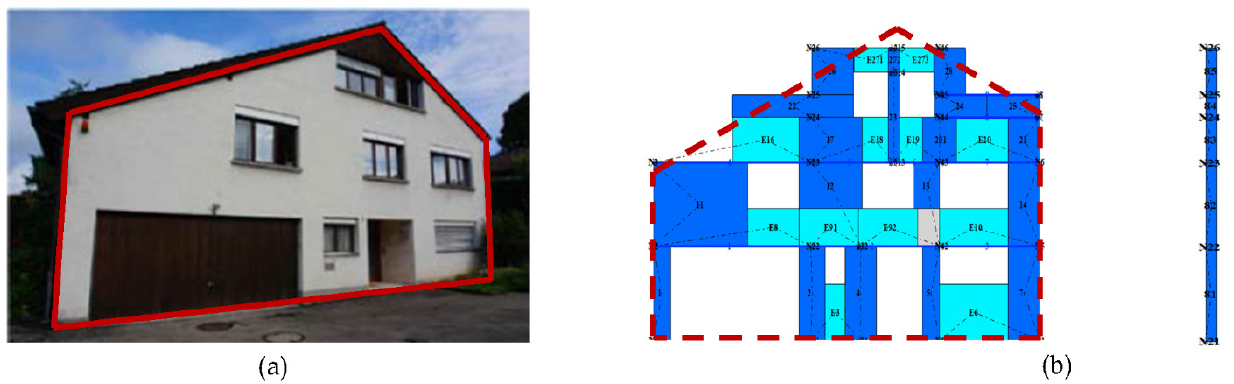
Figure 2. ( a ) South-east facade wall and ( b ) numerical model of the south-east facade wall in